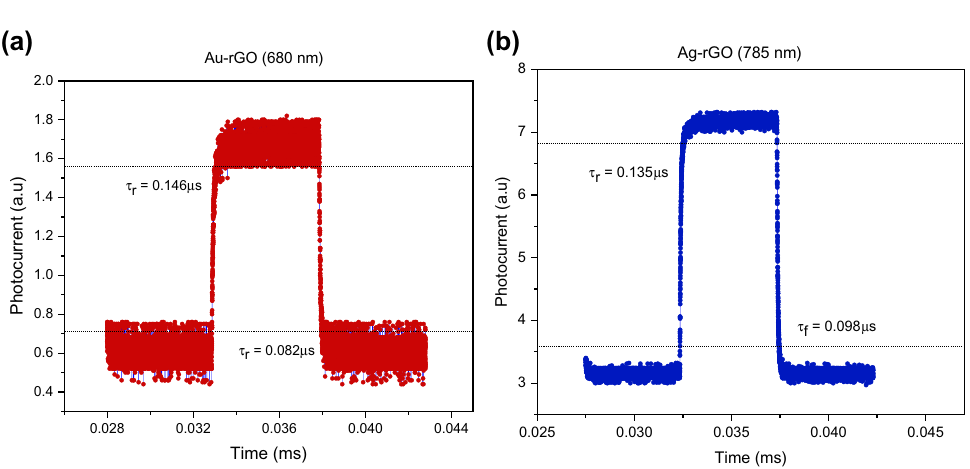
Figure 8. Rising and falling edges for estimating rise time (τ r ) and the fall time (τ f ) of ( a ) Au-rGO under 680 nm laser illumination and ( b ) Ag-rGO under 785 nm laser illumination. Both devices show best response time at particular